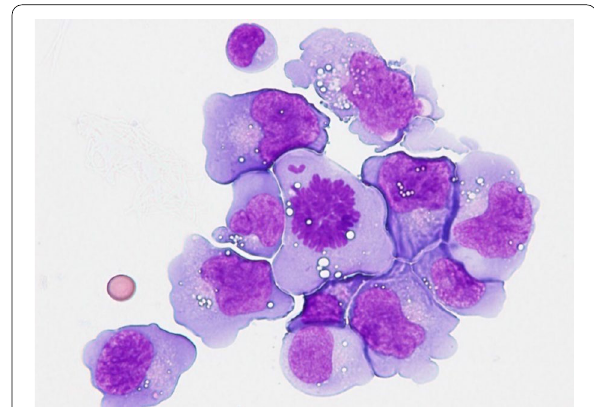
Fig. 2 Pleural effusion cytology and flow cytometry findings. Pleural effusion specimens processed using the cytospin centrifuge revealing abnormally huge cells suspected to be malignant lymphoma cells